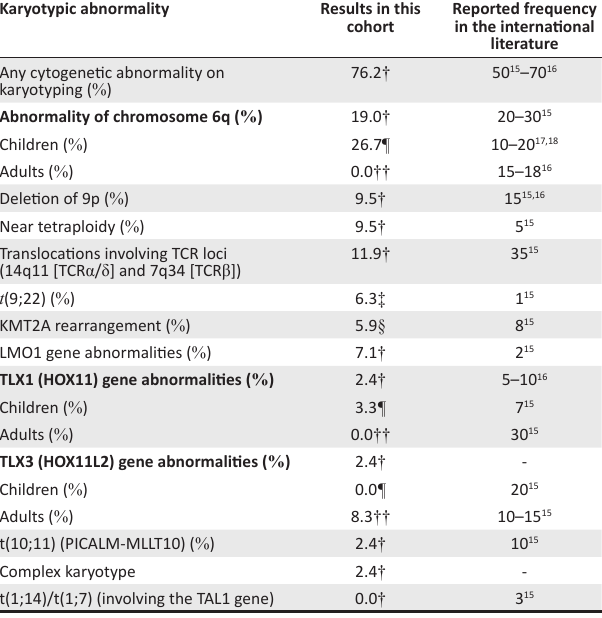
TABLE 2: Details of the cytogenetic results. Karyotypic abnormality Results in this